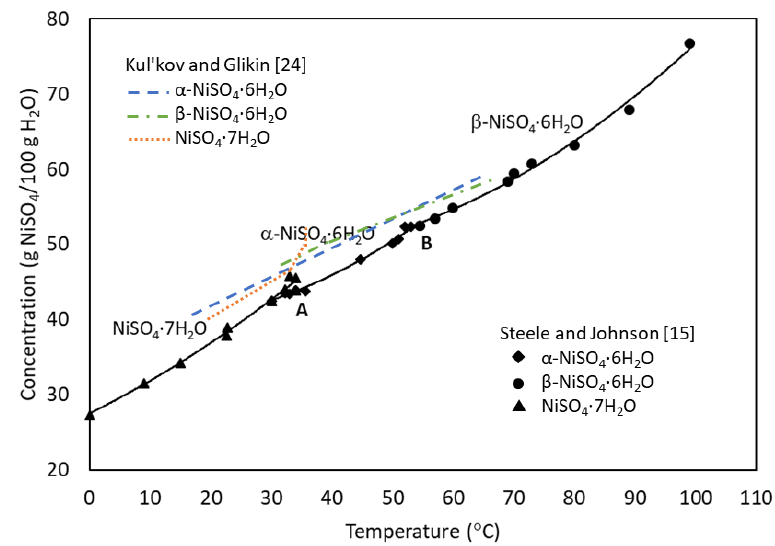
Figure 1. Solubility of nickel sulfate hydrates as a function of temperature, adapted from Refs [15,24]. Solubility curves in both studies show two eutonic points, A and B, representing the transition points for the thermodynamically most stable phase. Below 31.5–32 ◦ C, the pale green heptahydrate, NiSO 4 · 7H 2 O (morenosite), is the most stable phase in acid-free solutions and above this temperature nickel sulfate hexahydrate will form in solution. The transition point between the two hexahydrate polymorphs has been observed to be between 53–55 ◦ C [15,24]. Near eutonic points precipitation of nickel sulfate salts out of their stability regions and reversable phase transformation between phases are probable. Metastable equilibria here were shown to be comparable to thermodynamic equilibria.